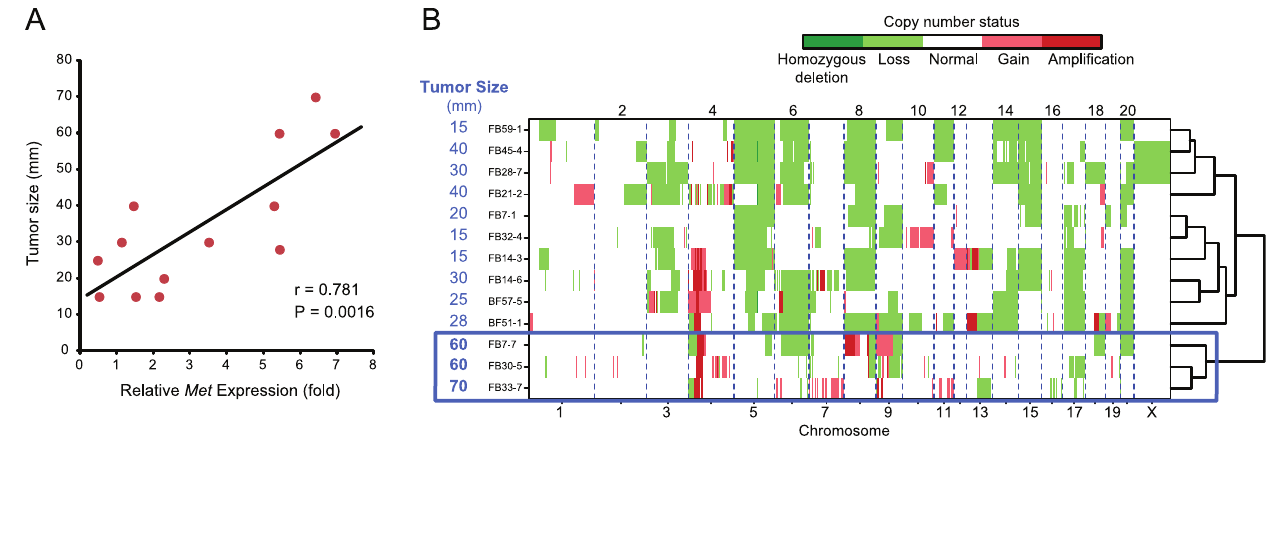
Figure 4. Tumor sizes of Fe-NTA induced RCCs are controlled by the genetic features. (A) Met expression is significantly correlated with tumor size. Pearson’s correlation coefficient (r) and the corresponding P value are written on the plot area. (B) Hierarchical clustering of the RCC tumors based on the whole genome patterns of the copy number changes. The large-size tumors form a distinct cluster. doi:10.1371/journal.pone.0043403.g004 PLOS ONE |